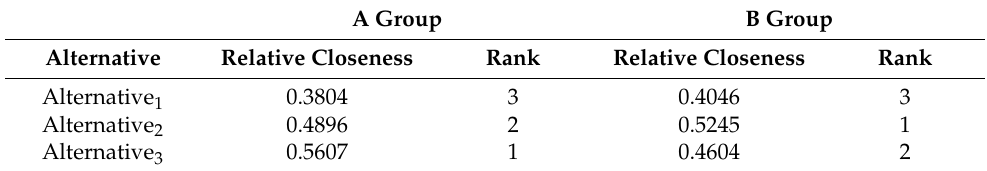
Table 9. Results from TOPSIS for both participant groups, when AIJ aggregated weights were used. A Group B